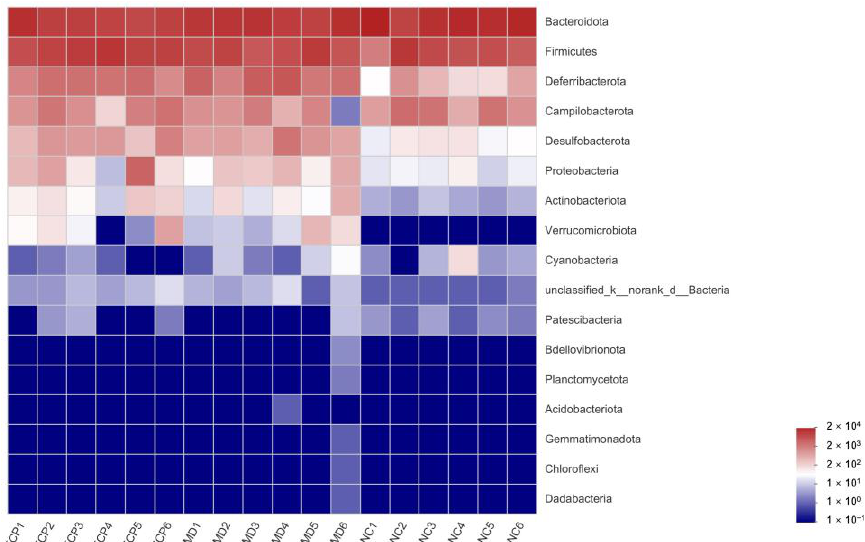
Figure 3. Heatmap analysis of the composition of the gut microbiota at the phylum level. The data are expressed as lg value.